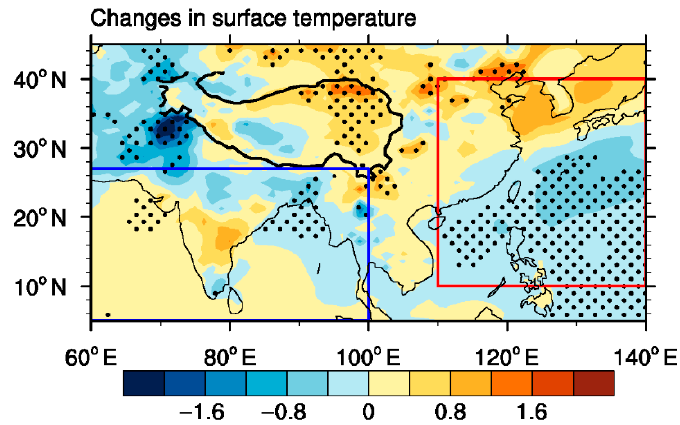
Figure 7. Changes in surface temperature (K) in the summer for period from 2001 to 2005. The area of the TP is enclosed by a black line. The dots denote the changes in surface temperatures that are significant above the 90% confidence level. The blue and red rectangles denote the areas to calculate the changes in the SASM and EASM indices, respectively.